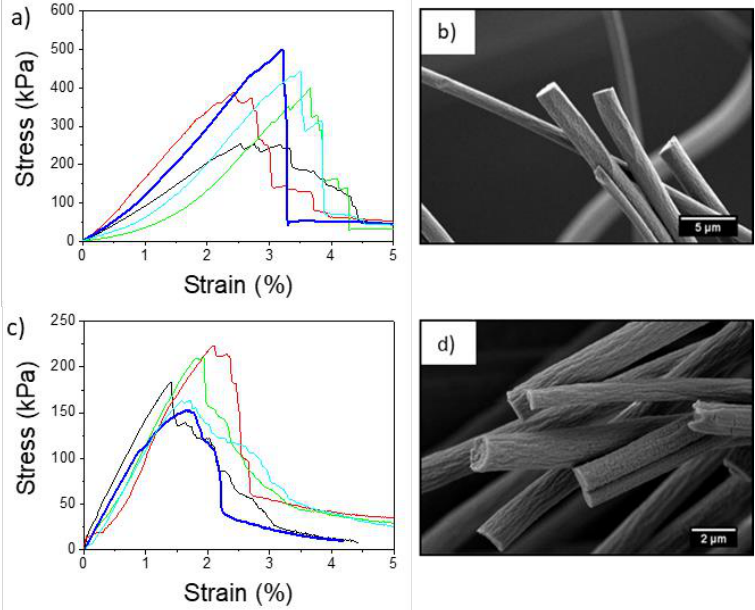
Figure 5. Stress-strain curve and scanning electron microscopy (SEM) images obtained after tensile testing of aligned PMMA fiber mats produced with a positively ( a , b ) versus negatively ( c , d ) charged spinneret.